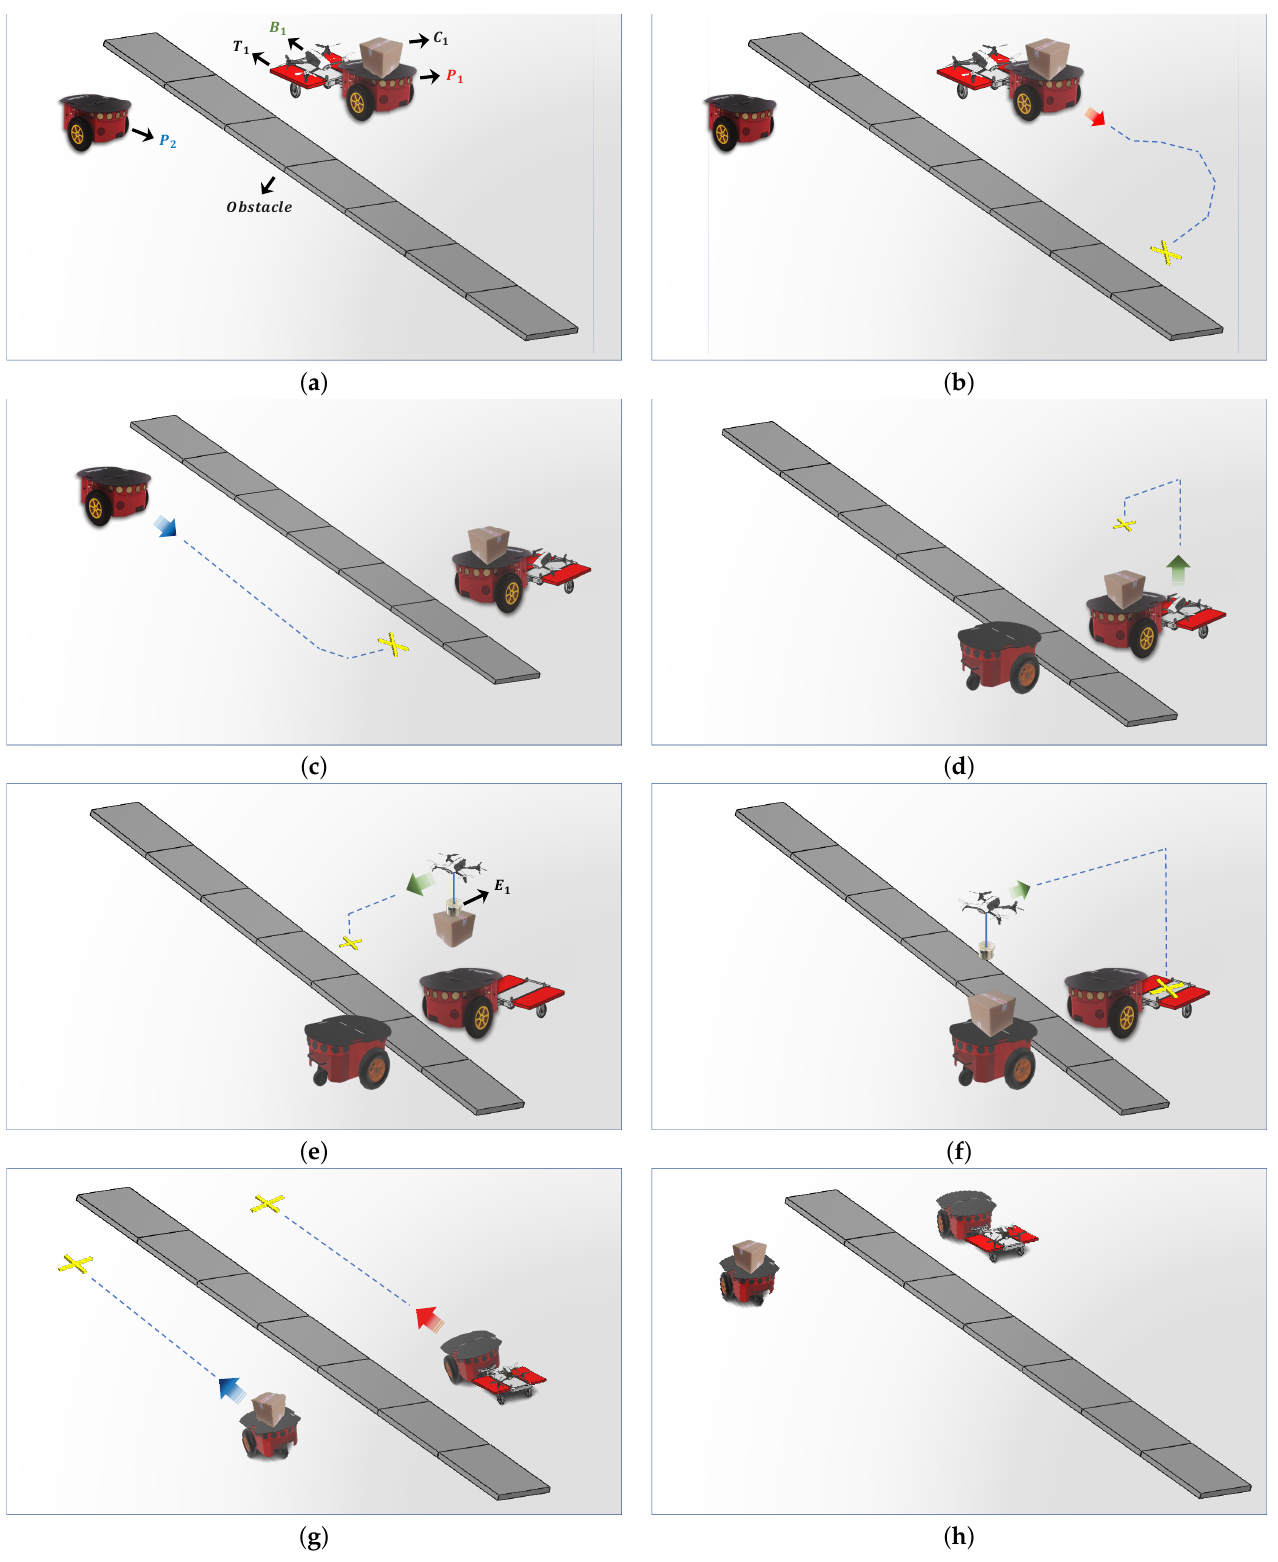
Figure 4. Sequence of events of formation during the experiment. ( a ) Agents of heterogeneous formation. ( b ) B1 starts moving towards the desired point. ( c ) P2 starts its movement to give assistance to P1. ( d ) B1 takes off to pick up C1. ( e ) B1 passes with C1 under the obstacle. ( f ) B1 delivers C1 on P2 and returns to T1 to land. ( g ) All formation returns to their respective destination. ( h ) Task is completed